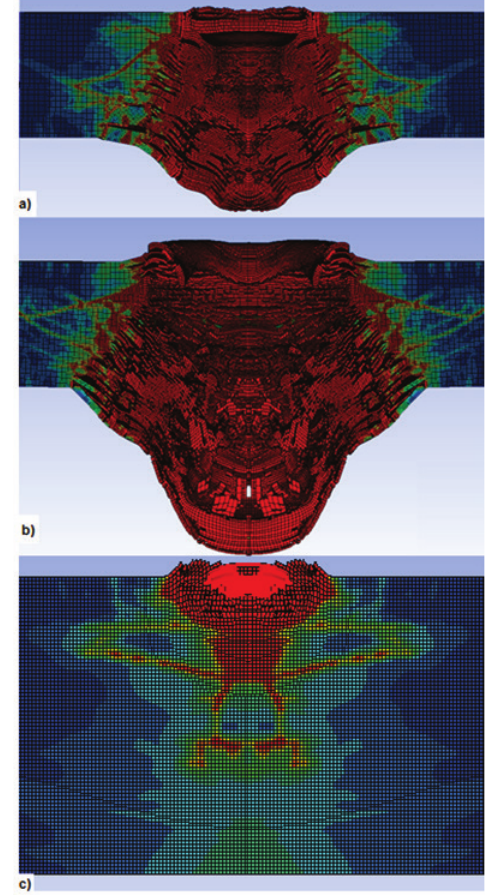
a) 2º Simulação em que foi utilizado um